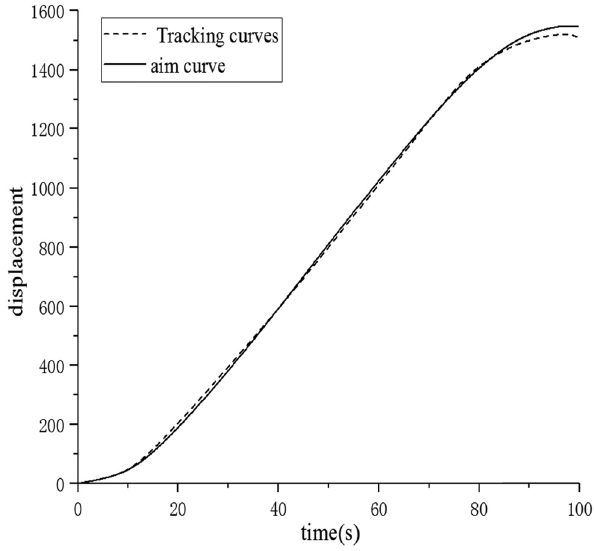
Figure 7: Ideal target curve and displacement tracking curve based on